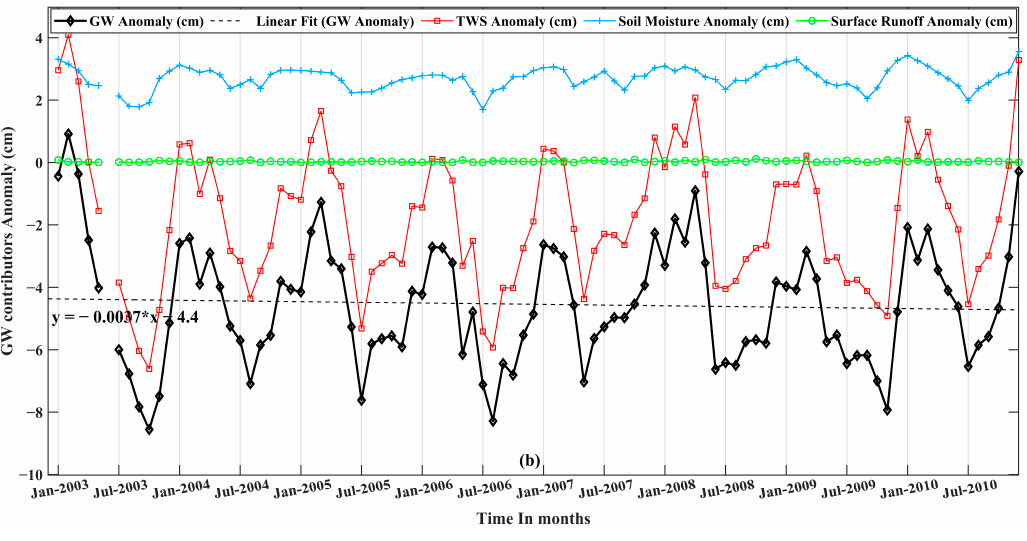
Figure 6. ( a ) Spatial variation of groundwater from GRACE (the red zones signifies larger groundwater depletion as compared to the blue zones). ( b ) Temporal variation of Terrestrial Water Storage (TWS) from GRACE (red line), soil moisture (blue line) and surface runo ff (green line) from GLDAS, resulting in groundwater (black line) and linear fit for groundwater (black dotted line).